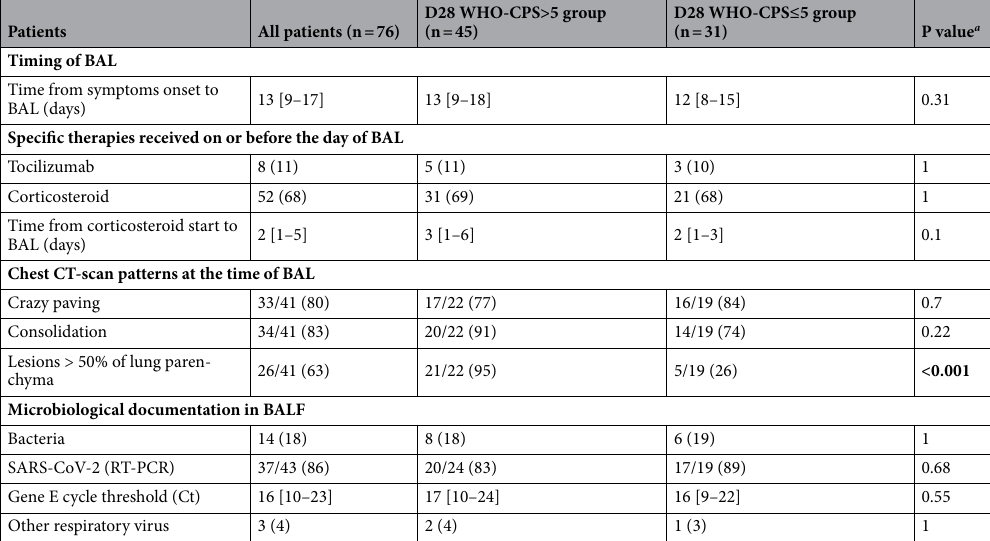
Table 2. Clinical and paraclinical data regarding bronchoalveolar lavage in critically ill COVID-19 patients, according to the 28-day WHO-CPS. Data are presented as median [first through third quartiles] or number (%). Patients were grouped according to their WHO-CPS value at 28-day. A score value higher than 5 (D28- WHO-CPS > 5) defined a poor 28-day outcome, whereas a score value equal or lower than 5 (D28-WHO- CPS ≤ 5) defined a good 28-day outcome. BAL bronchoalveolar lavage, BALF BAL fluid, chest CT-scan chest computed tomography scan, ICU intensive care unit, RT-PCR reverse transcriptase polymerase chain reaction, SARS-CoV-2 severe acute respiratory syndrome coronavirus 2, SOFA sequential organ failure assessment. a P values refer to differences between D28-WHO-CPS > 5 and D28-WHO-CPS ≤ 5 groups. Boldface values indicate statistically significant differences between the